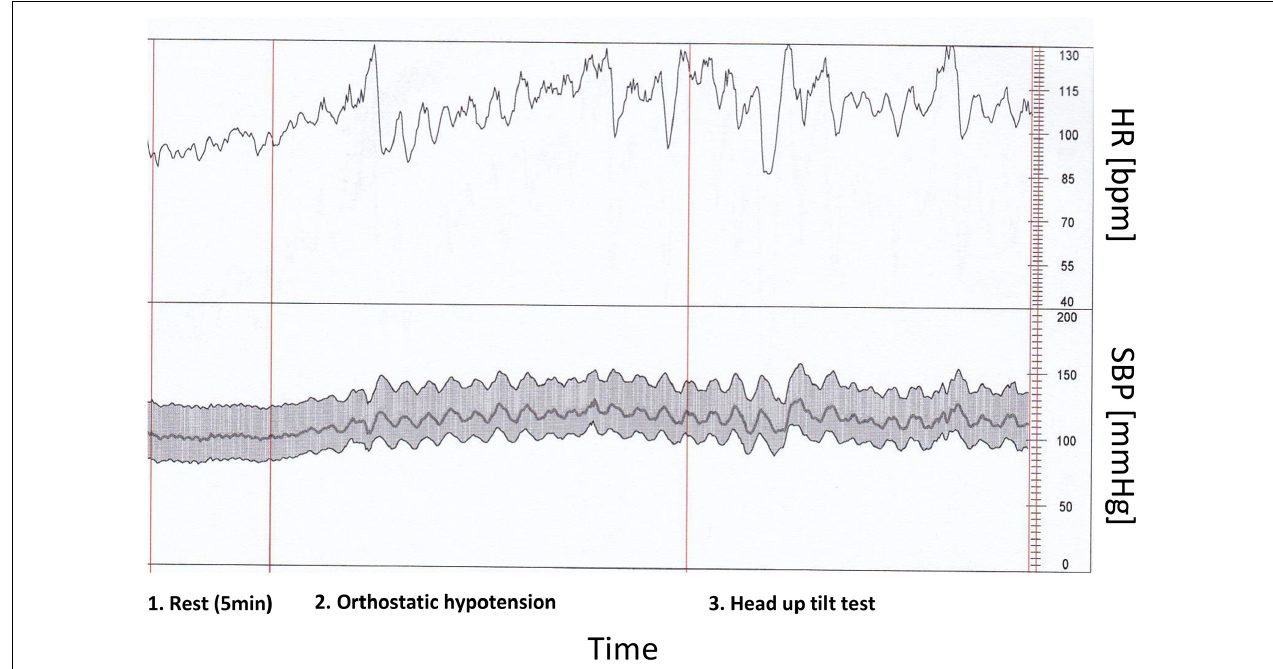
FIGURE 2 | Heart rate and characteristic blood pressure variability in rest and during orthostatic hypotension and head up tilt test by patient with COVID-19 infection and low baroreflex sensitivity (real time beat to beat blood pressure